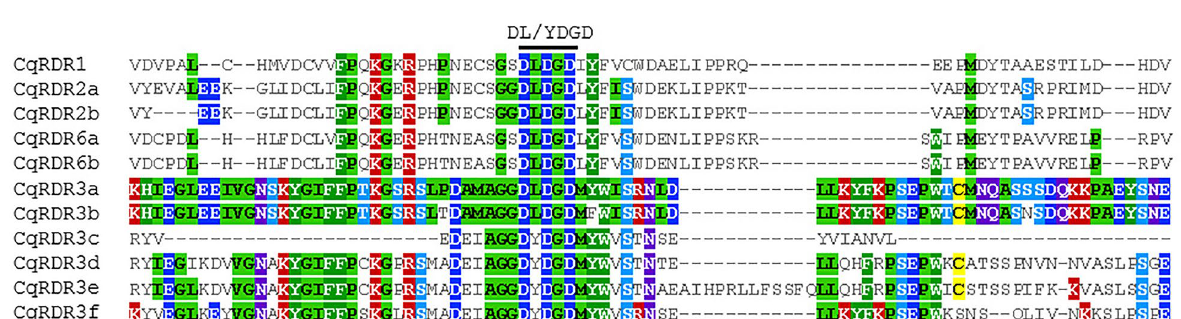
Figure 5. Functionally conserved amino acids in CqDCL proteins. ( A ) NLL motif and connector helix core L/ IPSI/L/VM/I(X)11LK/R. ( B ) RNase III A TEKCHER motif, N, and K residues. ( C ) RNase III B HPSYN motif, N, and K residues.